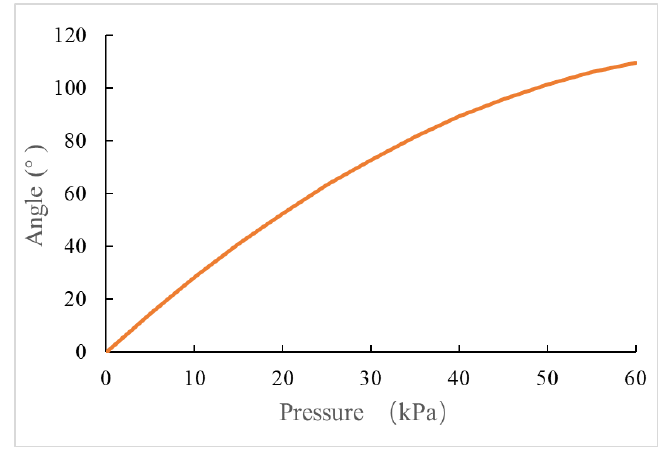
Figure 10. Relationship between bending angle and inflation pressure.